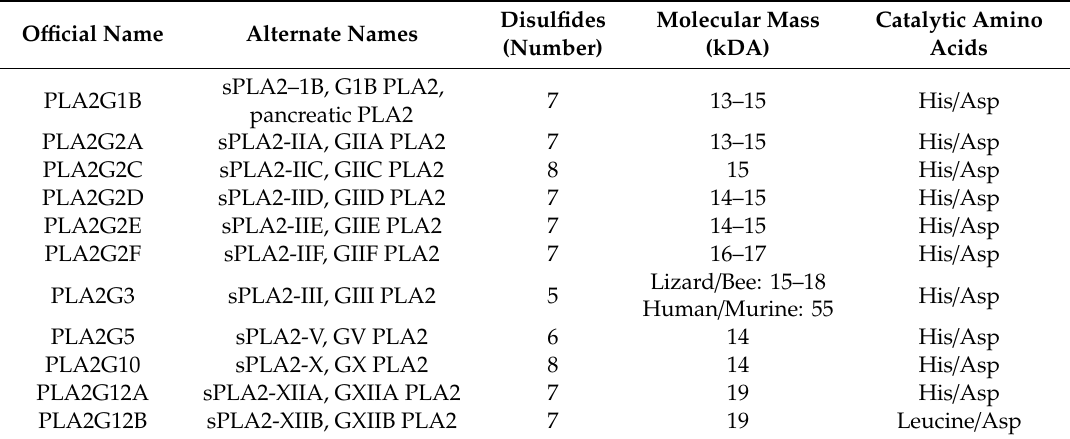
Table 1. Classification of secretory phospholipases A